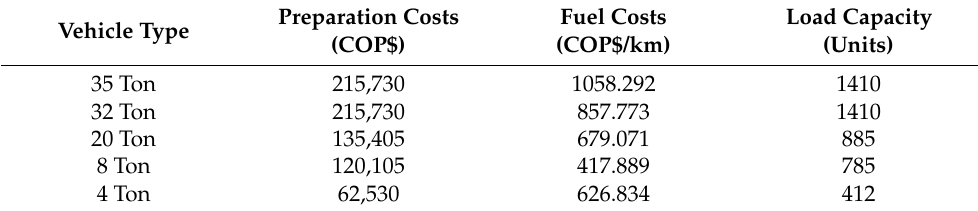
Table 6. Vehicle